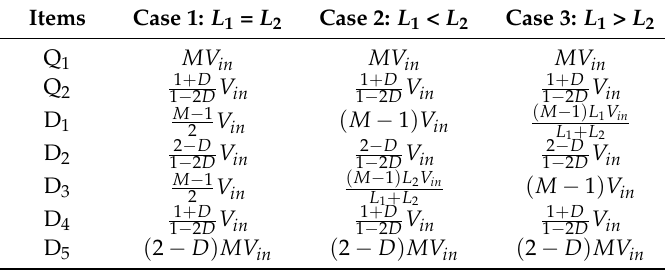
Table 2. Voltage stress on power switches and diodes.